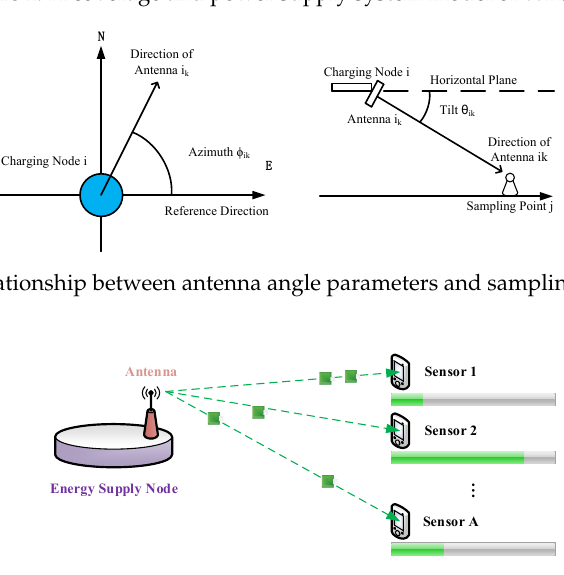
Figure 1. A coverage and power supply system model of WRSNs.